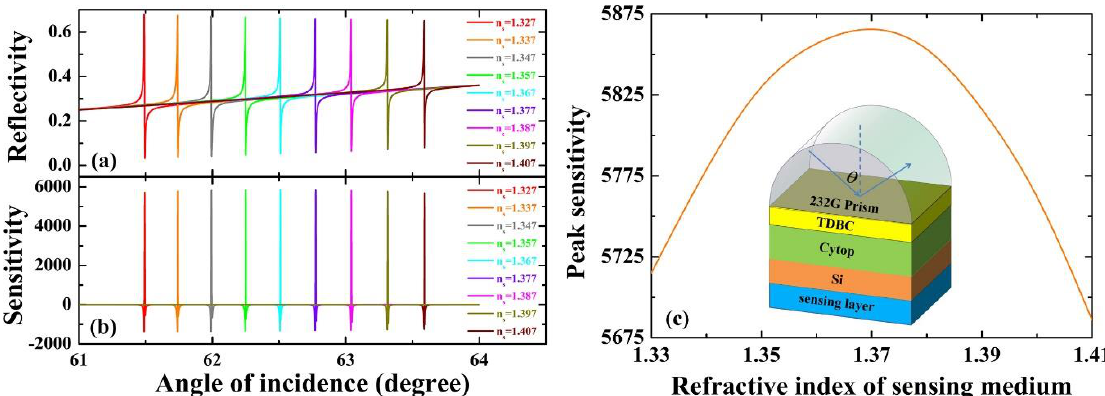
Figure 6. ( a , b ) The variations of reflectivity and sensitivity with a different refractive index of sensing medium, λ = 532 nm, d 1 = 35nm, d 2 = 300 nm, and d 3 = 62 nm. ( c ) The peak sensitivity varies with the refractive index of sensing medium.